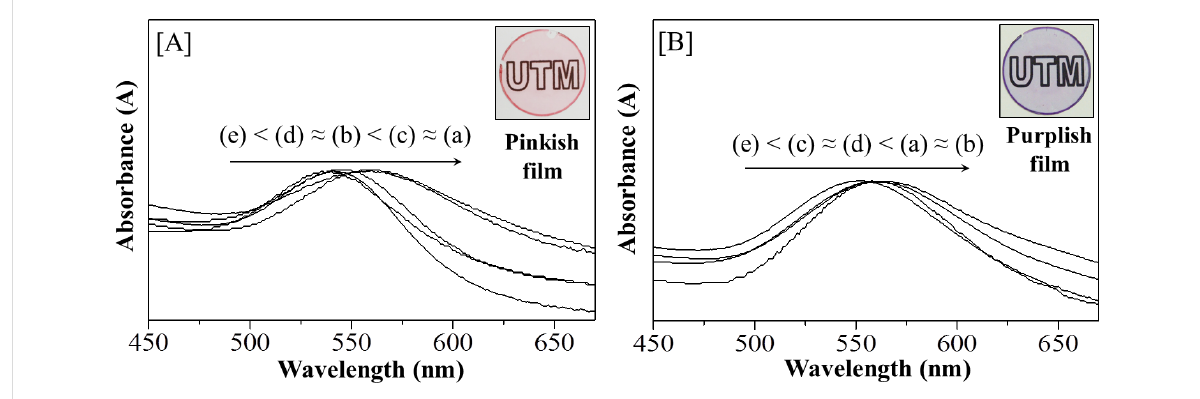
Figure 8: Absorption spectra of a) [AuNPs] cal /silica hex and b) [AuNPs] red /silica hex films at (a) 190, (b) 210, (c) 230, (d) 250 and (e) 450 °C. The insets show representative photography images for the as-synthesized films after both heat treatments.